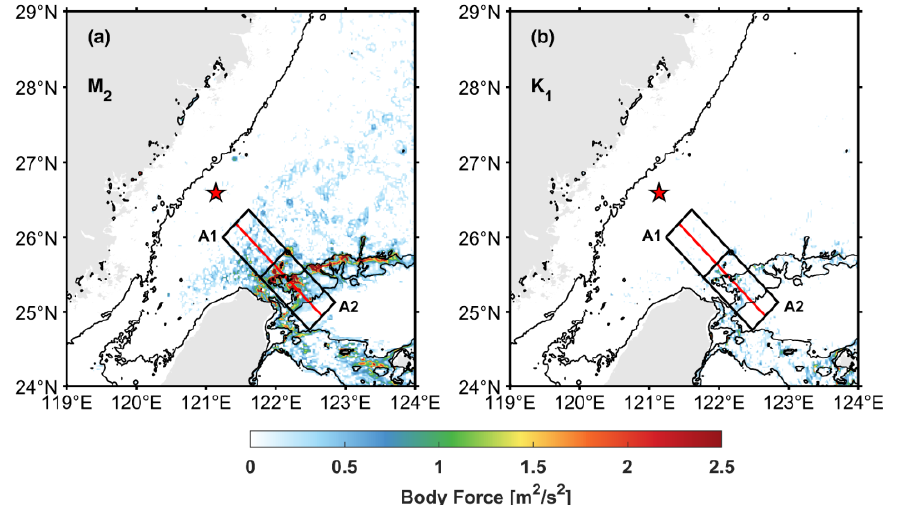
Figure 6. Body forces for ( a ) semidiurnal (M 2 ) and ( b ) diurnal (K 1 ) internal tides. The black solid lines indicate the 50, 200, and 1000 m isobaths. The red star indicates the mooring location. The red solid line indicates the possible propagation path of a remotely generated internal tide. The black box indicates the area of integration in Table 2. A1 (the upper box) represents the shelf generation region, A2 (the lower box) represents the slope generation region. Table 2. Integration of M 2 and K 1 body forces in the generation domain (black box shown in Figure 5) for each month.